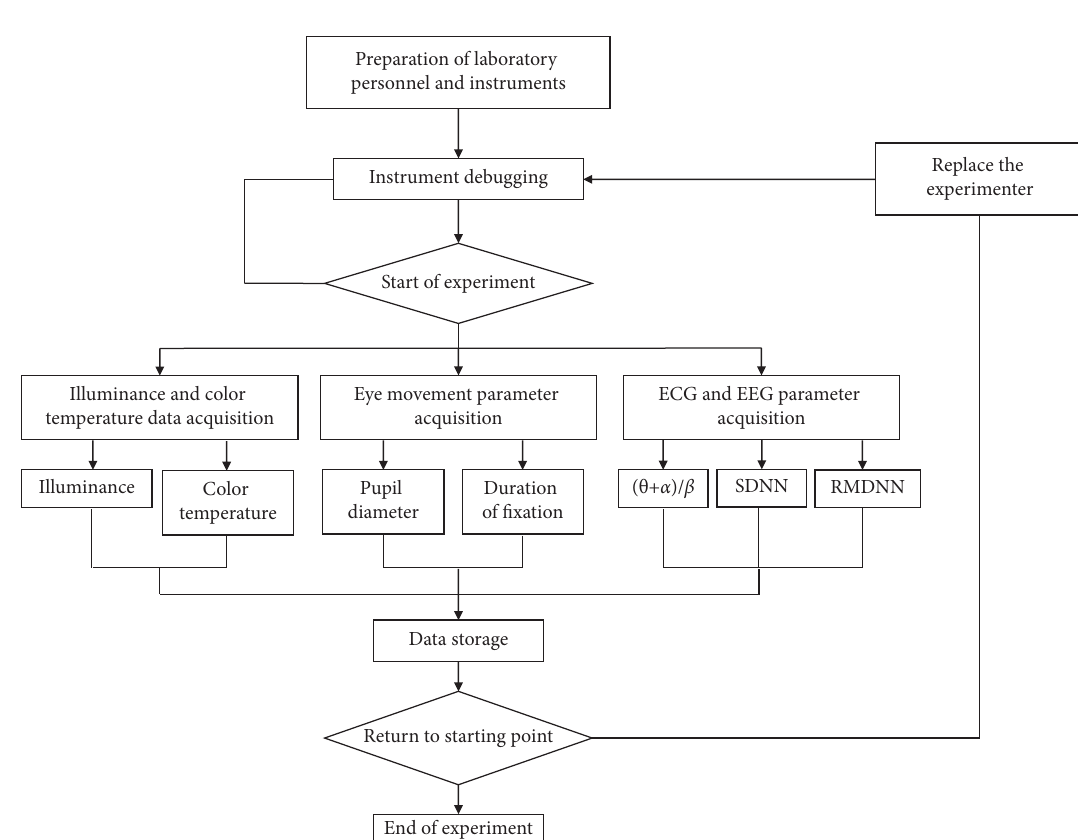
Figure 4: Flowchart of the experimental